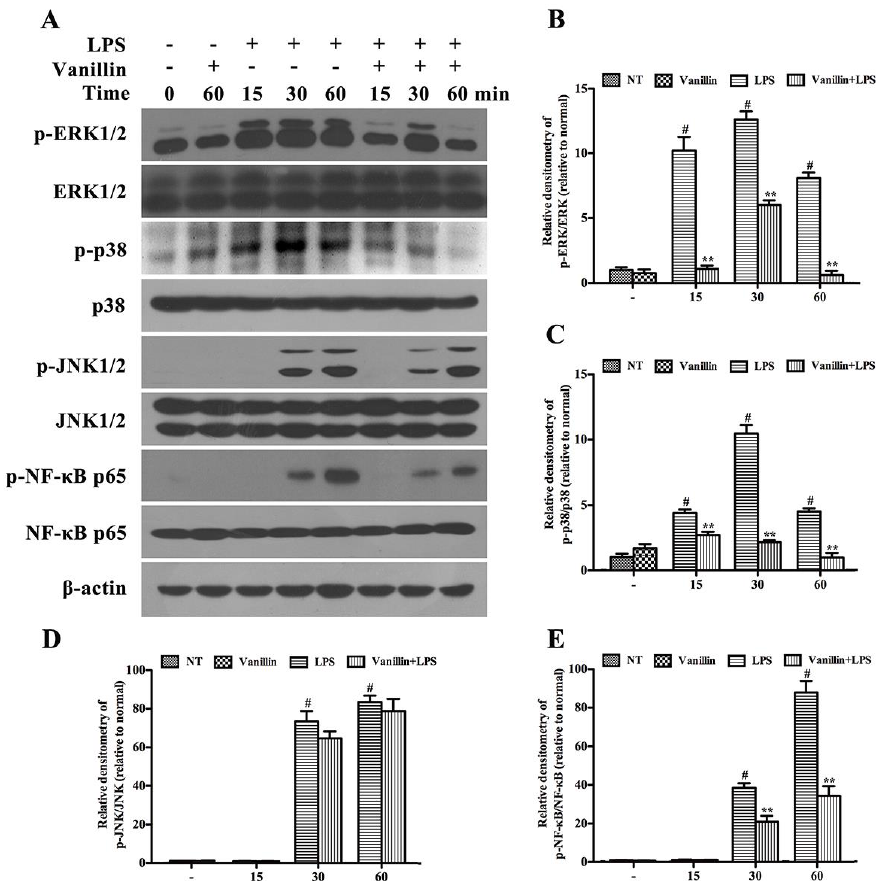
Figure 6. Vanillin regulates MAPKs and NF-κB activation in LPS-stimulated BV-2 cells. ( A ) the expression of MAPKs and NF-κB p65 was examined via Western blot. The phosphorylation ratio of ERK1/2 ( B ); p38 ( C ); JNK1/2 ( D ); and NF-κB p65 ( E ) was quantified. Each value was then expressed relative to the control (LPS no treatment), which was set as 1.00. # p < 0.01 vs. no control. ** p < 0.01 vs. treated with LPS alone within the same time point.